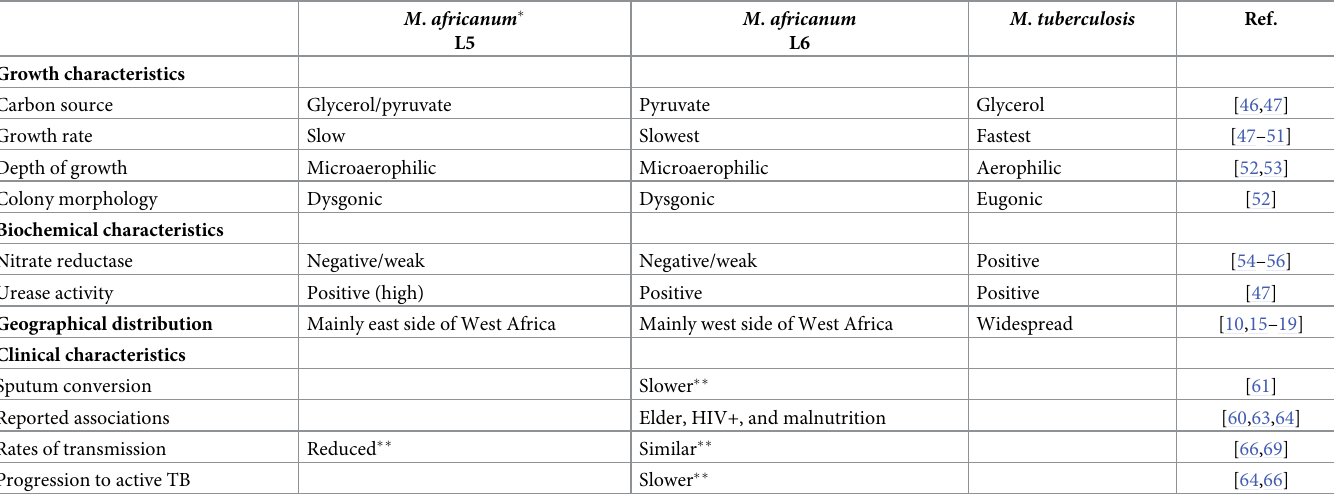
Table 1. Main differences discriminating M . africanum and M . tuberculosis